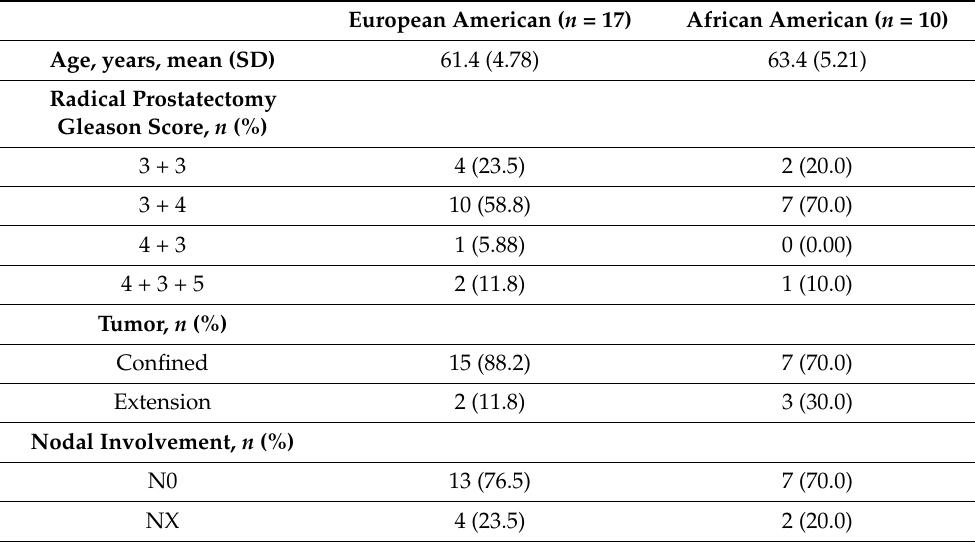
Table 1. Patient demographics and clinical